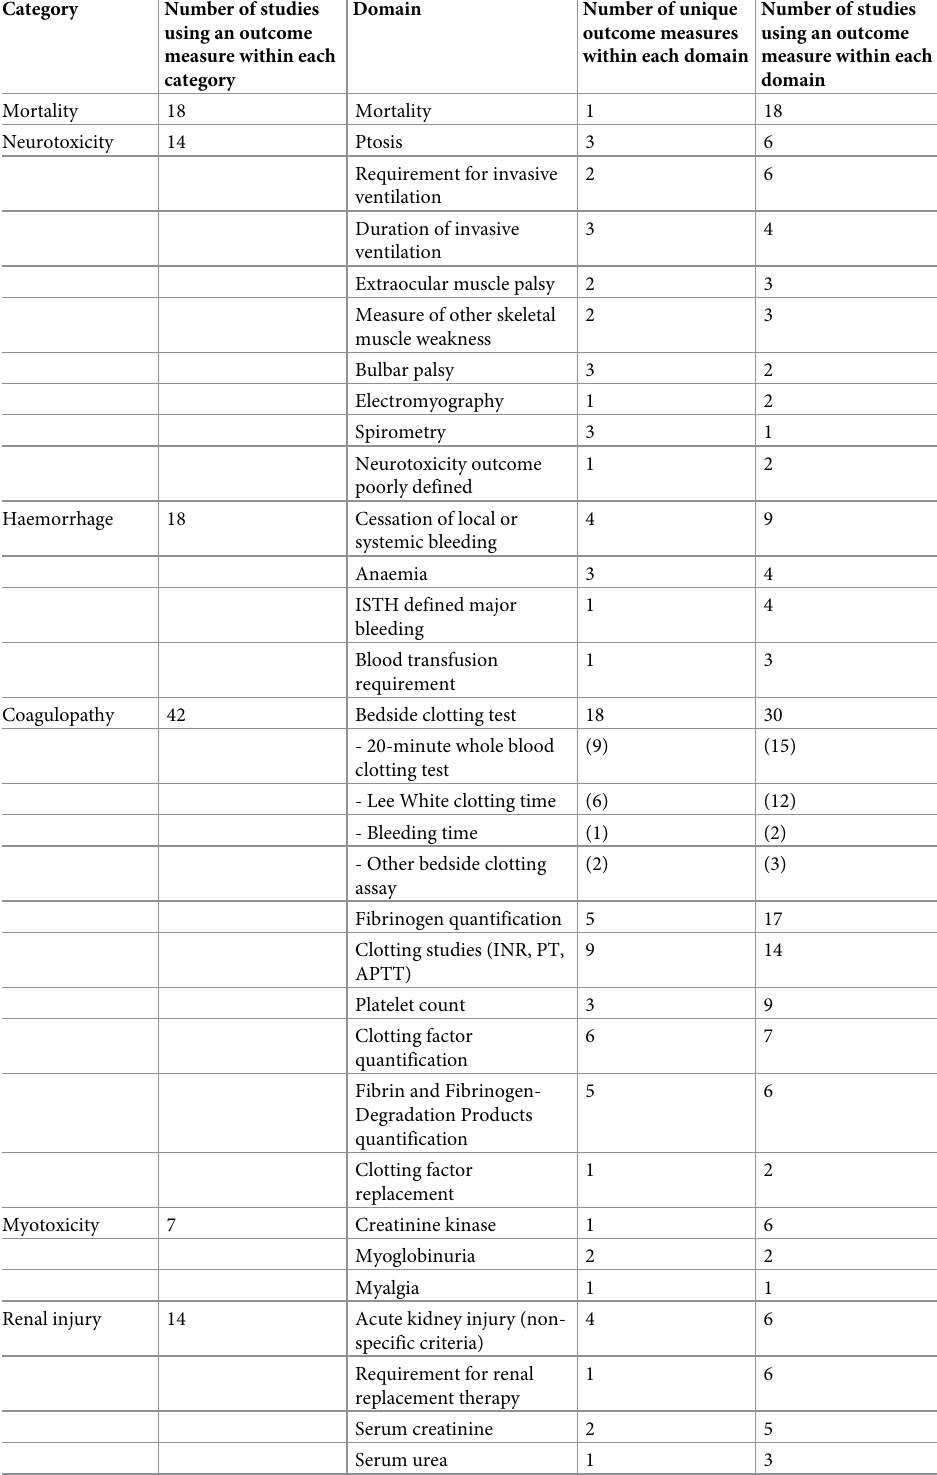
Table 2. Overview of outcome categories and